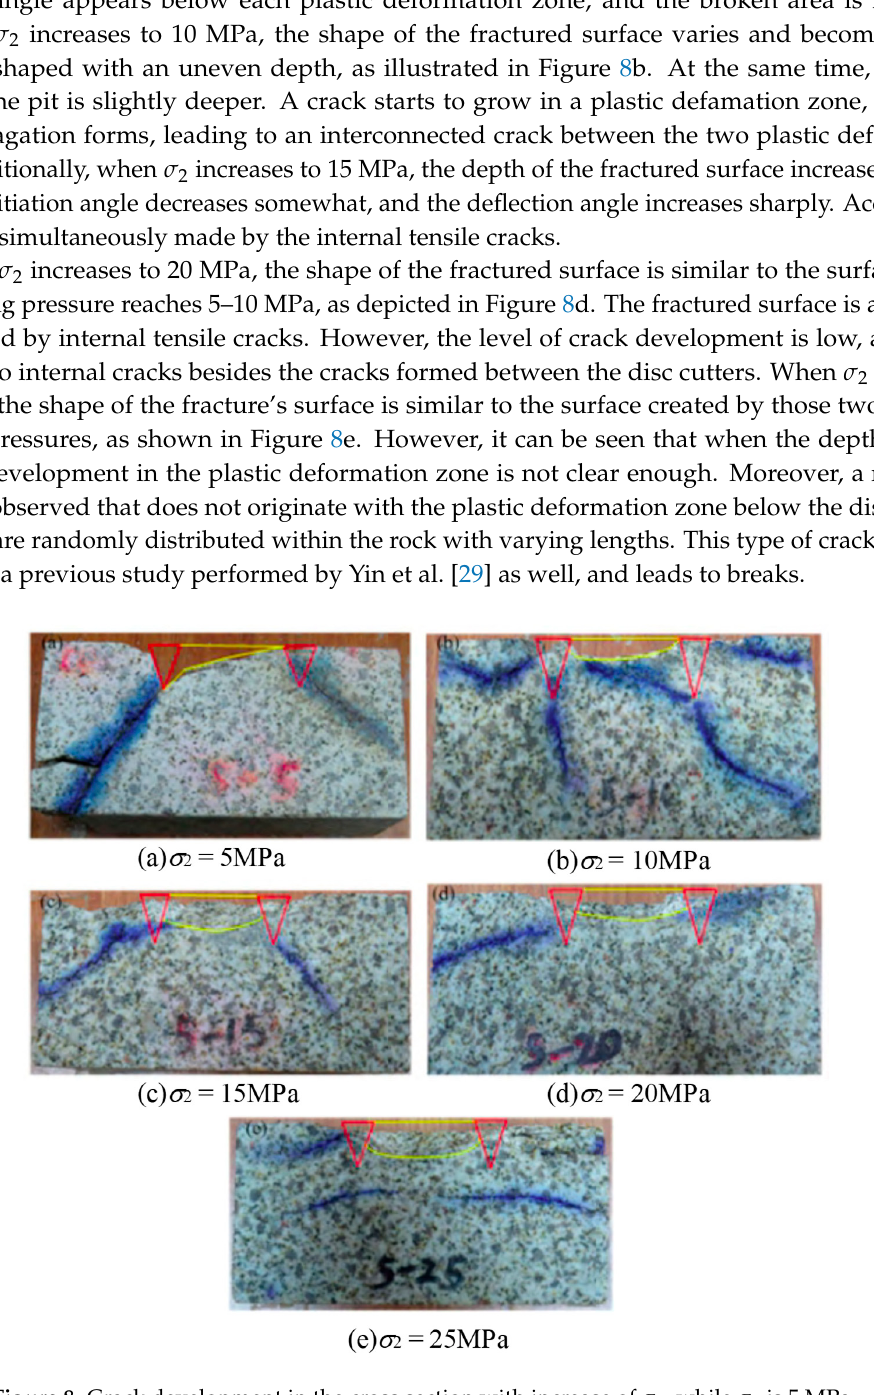
Figure 7. Variations of fractured surface with increase of σ 1 while σ 2 is constant at 25 MPa.